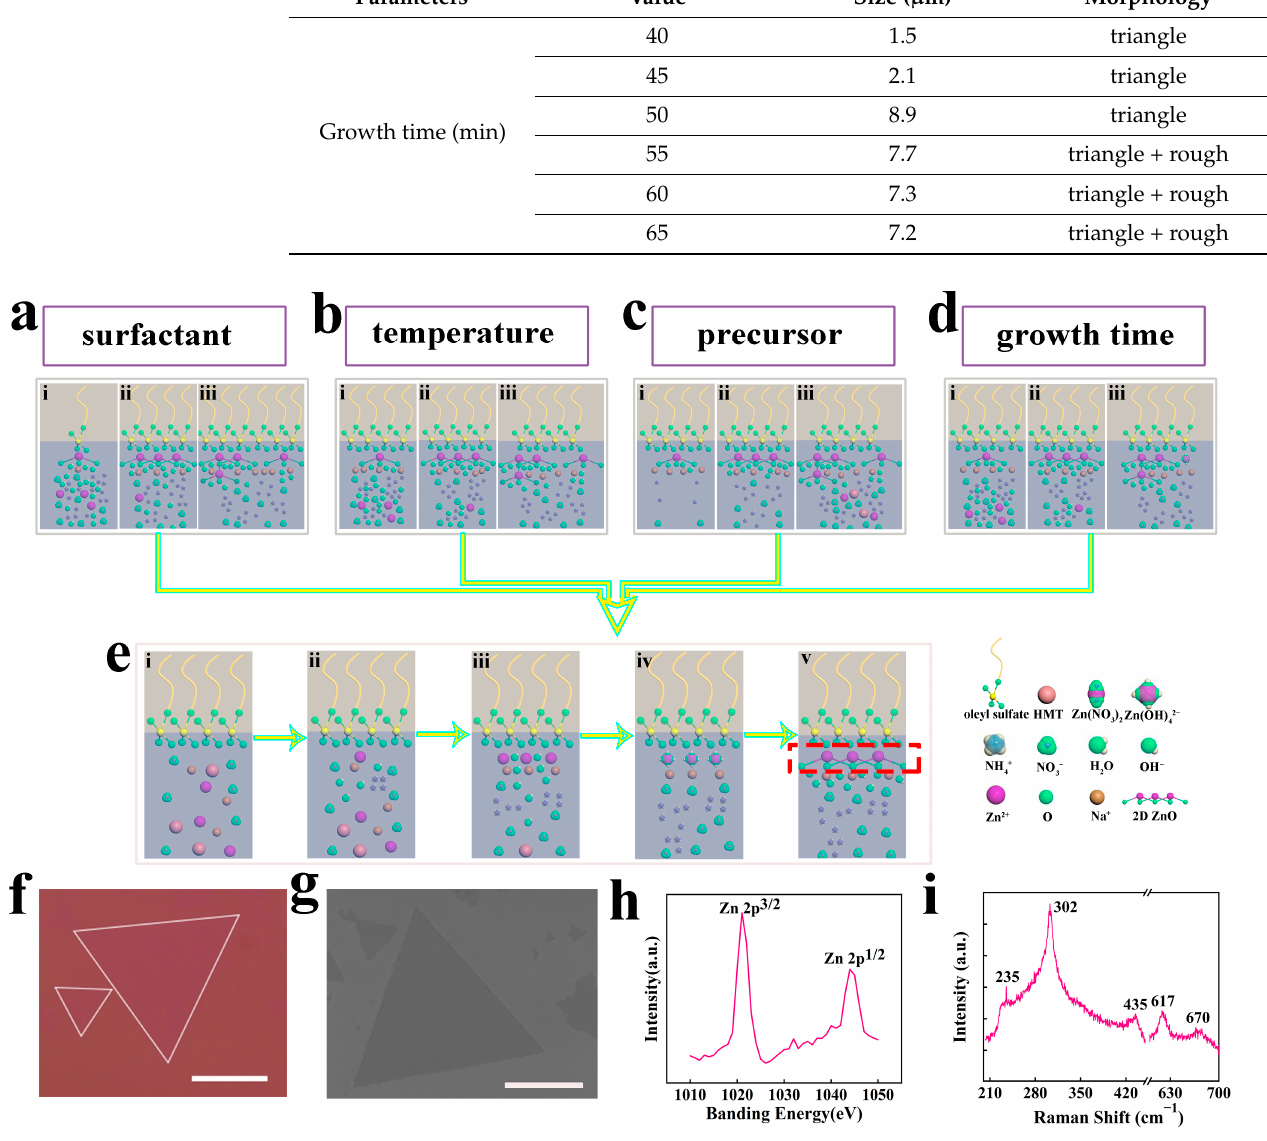
Figure 5. Mechanism analysis of 2D ZnO synthesis by SA-ILE. Schematic diagram of the synthesis of 2D ZnO while controlling ( a ) the ratio of sodium oleyl sulfate to Zn 2 + (i): lower than 10 × 10 − 5 , (ii): 10 × 10 − 5 , (iii): higher than 10 × 10 − 5 , ( b ) temperature (i): lower than 70 °C, (ii): 70 °C, ( iii ): higher than 70 °C . ( c ) precursor (i): lower than 50 mM, (ii): 50 mM, (iii): higher than 60 mM and ( d ) growth time (i): lower than 50 min, (ii): 50 min, (iii): higher than 50 min. ( e ) Diagram illustrates the nucleation and growth of 2D ZnO. The red dotted box indicated the formation of 2D ZnO at the water-air interface. ( f ) Optical image of 2D ZnO. Scale bar is 5 μ m. ( g ) SEM image of 2D ZnO. Scale bar is 5 µ m. ( h ) XPS spectrum of 2D ZnO. ( i ) Raman spectrum of 2D Table 1. Effect of the above parameters on 2D ZnO growth.